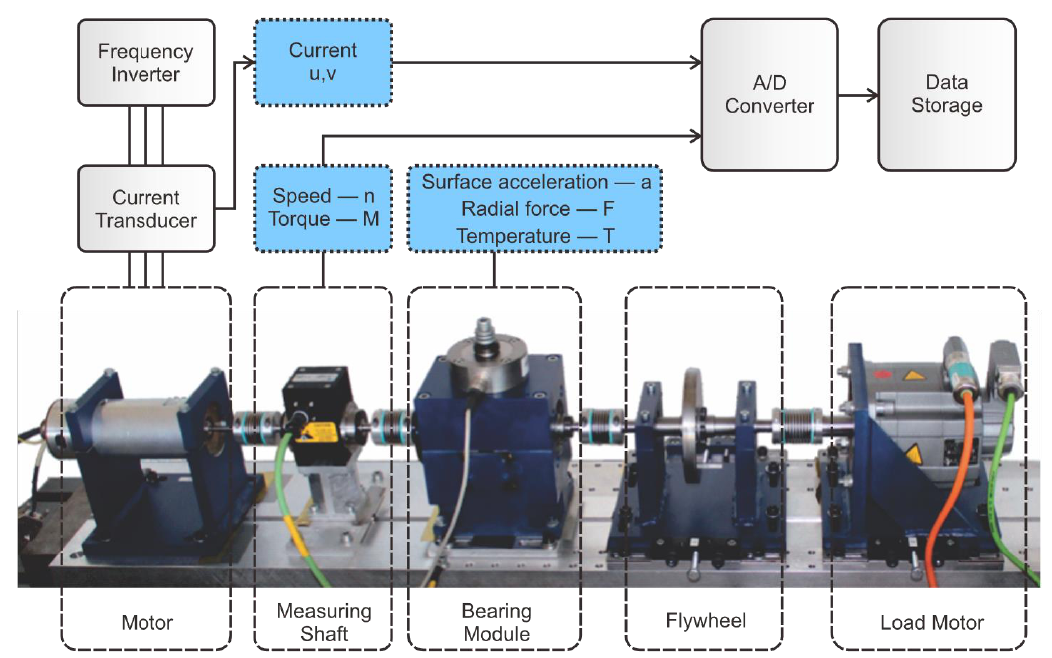
Figure 1. Modular test rig used for PU data collection.